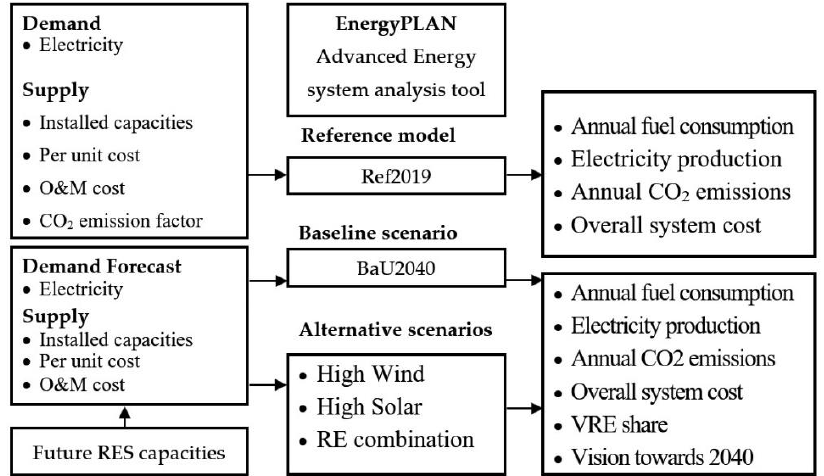
Figure 4. Structure of the electricity model of Pakistan in EnergyPLAN.